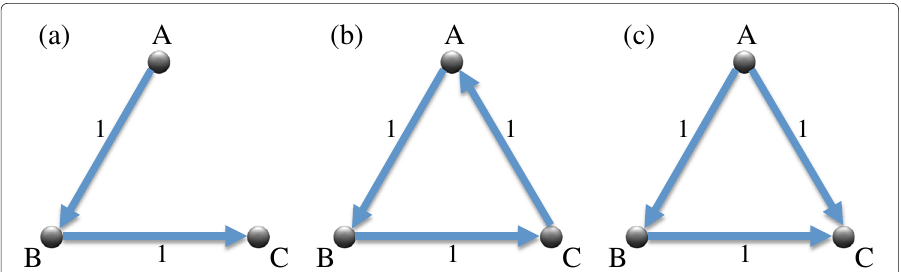
Fig. 1 Examples of triangular transaction networks. A completely hierarchical network ( a ), a completely circular network ( b ) and a mixed network with bowth hierarchical and circular characteristics ( c